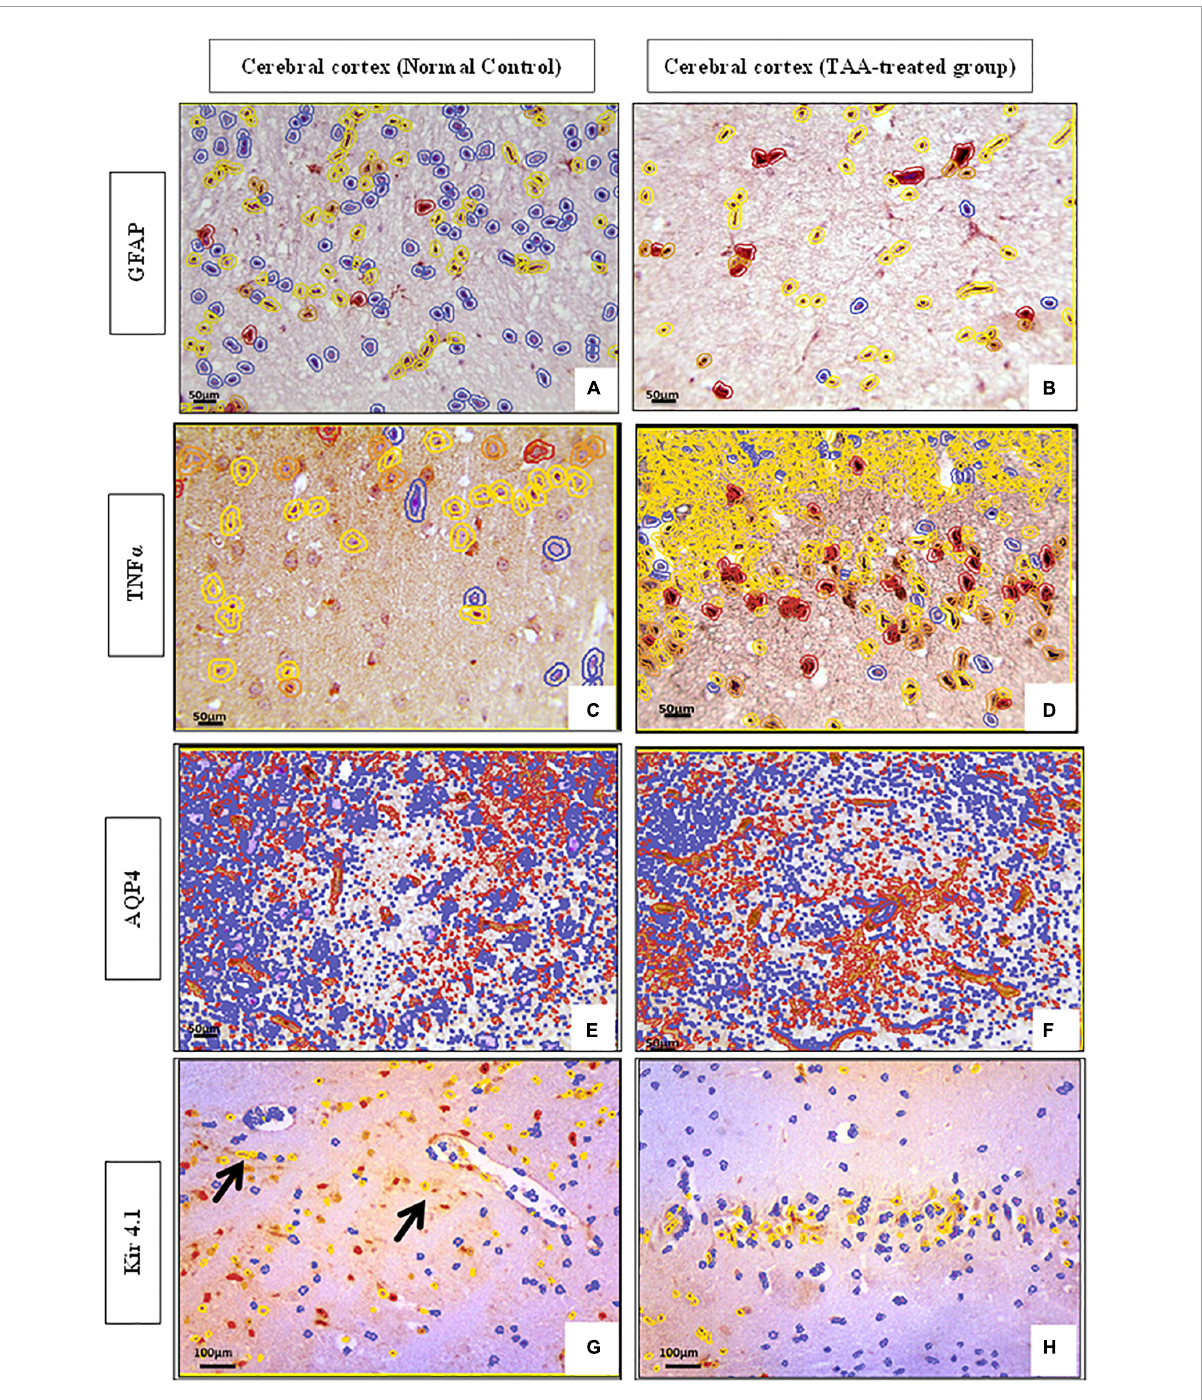
FIGURE11 (A–H) QuePath Quantification of microscopic pictures of immunostained cerebral cortical sections of control and treated groups. (A,B) Cerebral cortical sections against (GFAP) showing increased intensity in TAA-treated group as indicated by an increase in the red color of astrocytes (B) when compared with control group (A) , which showed an increase in blue color. (C,D) Cerebral cortical sections against (TNF α ) showing increased intensity in TAA-treated group as indicated by an increase in the yellow and red color of astrocytes (B) as compared with the Control group (A) , which showed a decrease in red and yellow color. (E,F) Cerebral cortical sections against (AQP4) showing increased intensity in TAA-treated group as indicated by an increase in orange and red color in the blood vessels and membranes of astrocytes (B) when compared with control group (A) , which displayed a decrease in red color. (G,H) Cerebral cortical sections against (Kir4.1) showing decreased intensity in TAA-treated group as indicated by a decrease in the orange and red color of astrocytes (B) as compared with the Control group (A) , which showed an increase in red color and yellow color in astrocytes, especially near blood vessels (black arrows). X: 400 bar 50 and X: 200 bar